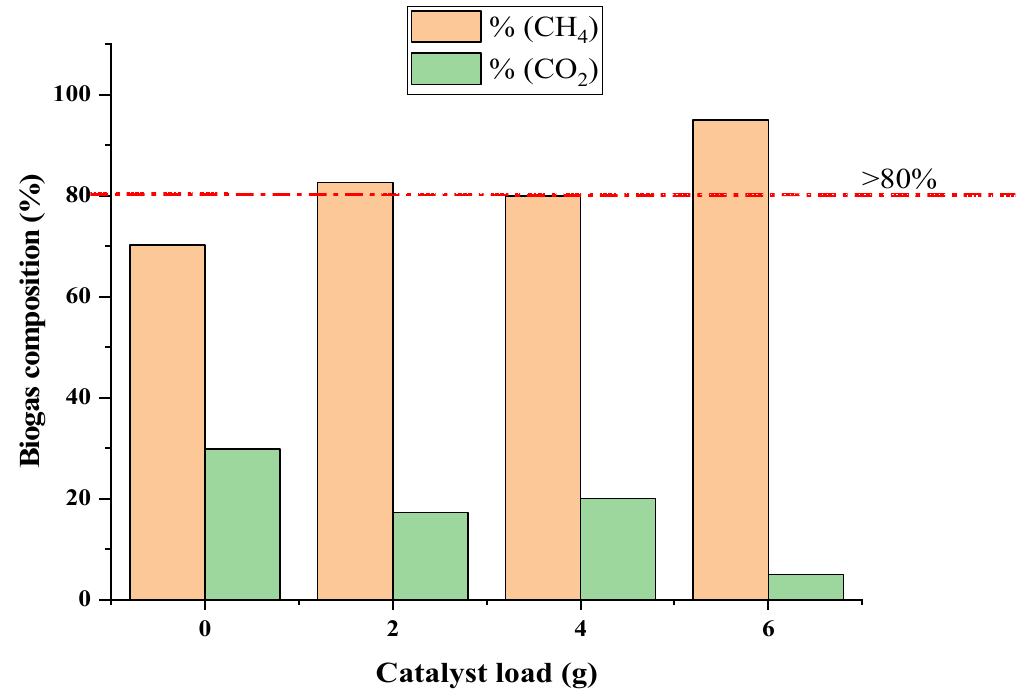
Figure 4. The effect of weekly catalyst load of Fe-TiO 2 on methane yield using the biophotocatalytic system Table 3. The estimated energy cost of the BP system biogas produced from wastewater